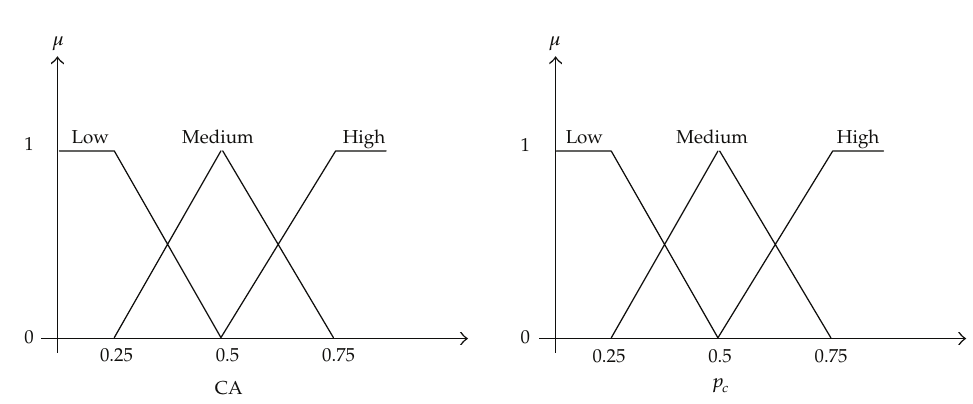
Figure 3: The set of linguistic labels associated with CA and p c